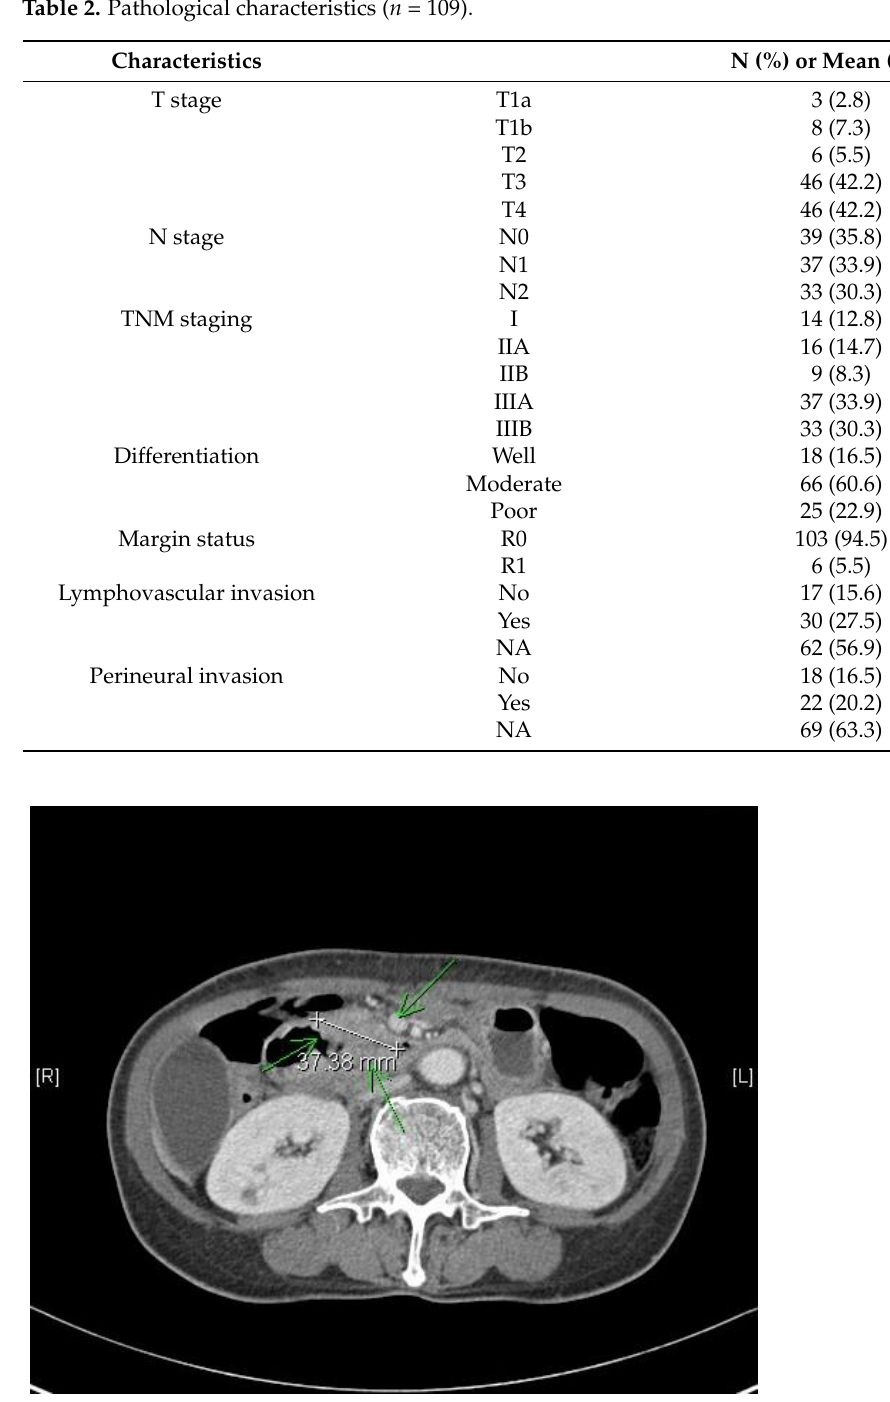
Figure 1. Illustration of non-ampullary duodenal adenocarcinoma. The green arrows indicate the duodenal adenocarcinoma from a 57 years old female patient, about 37 mm size tumor.